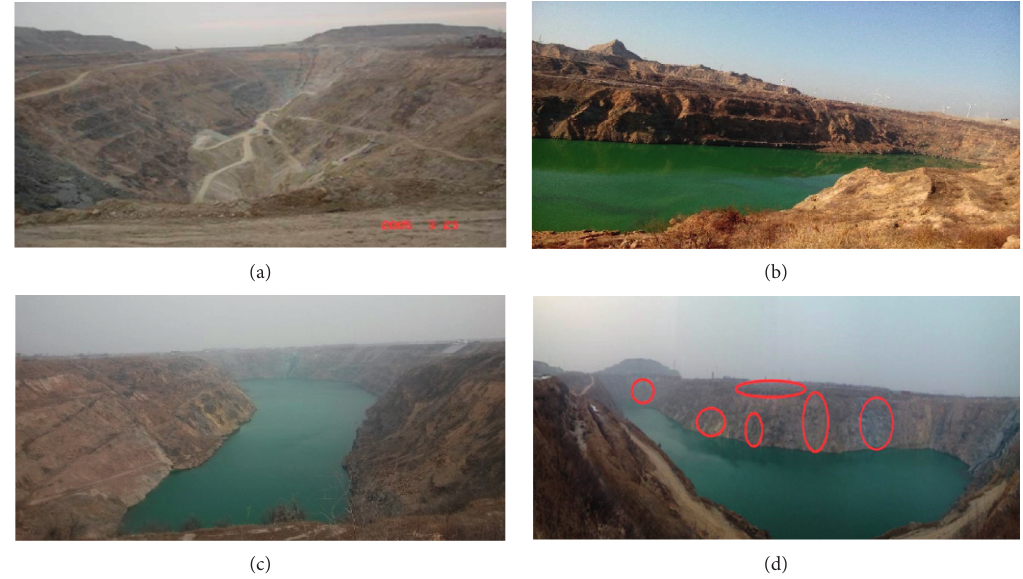
Figure 1: Cyclic invasion-dehydration process in open pit. (a) Open pit without water. (b) Water level rise. (c) Water level decline. (d) Open pit slope deformation.